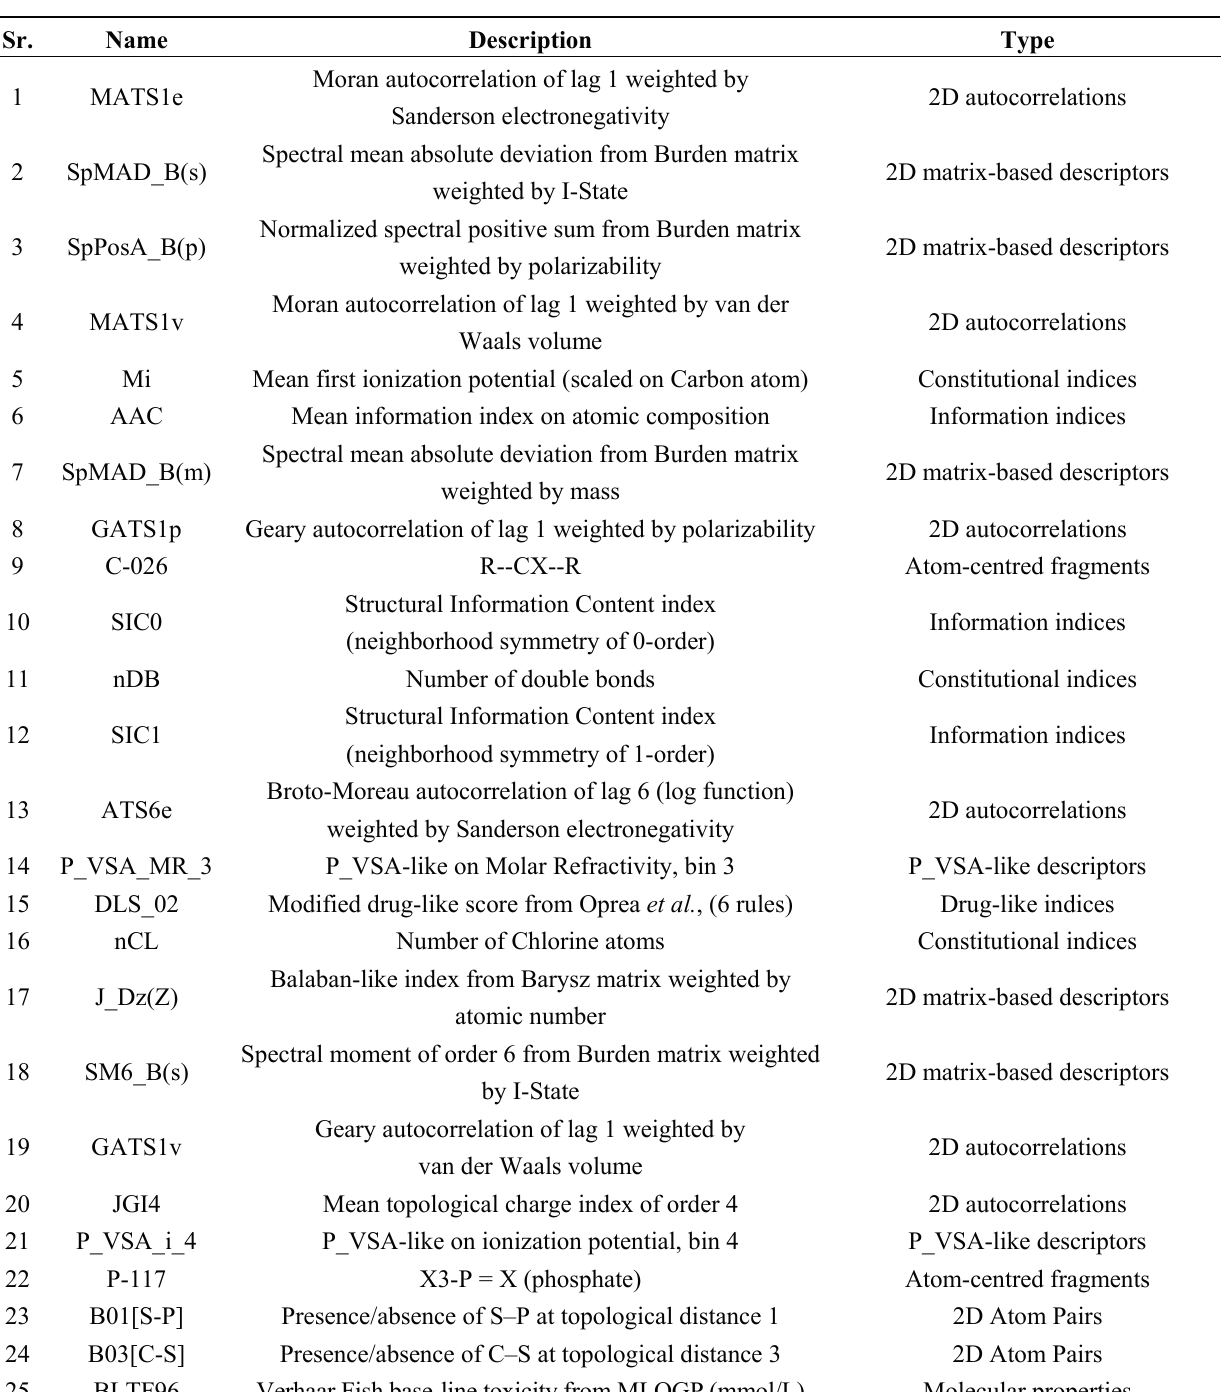
Table 3. Description of the 25 descriptors derived by the genetic algorithm coupled with k -NN